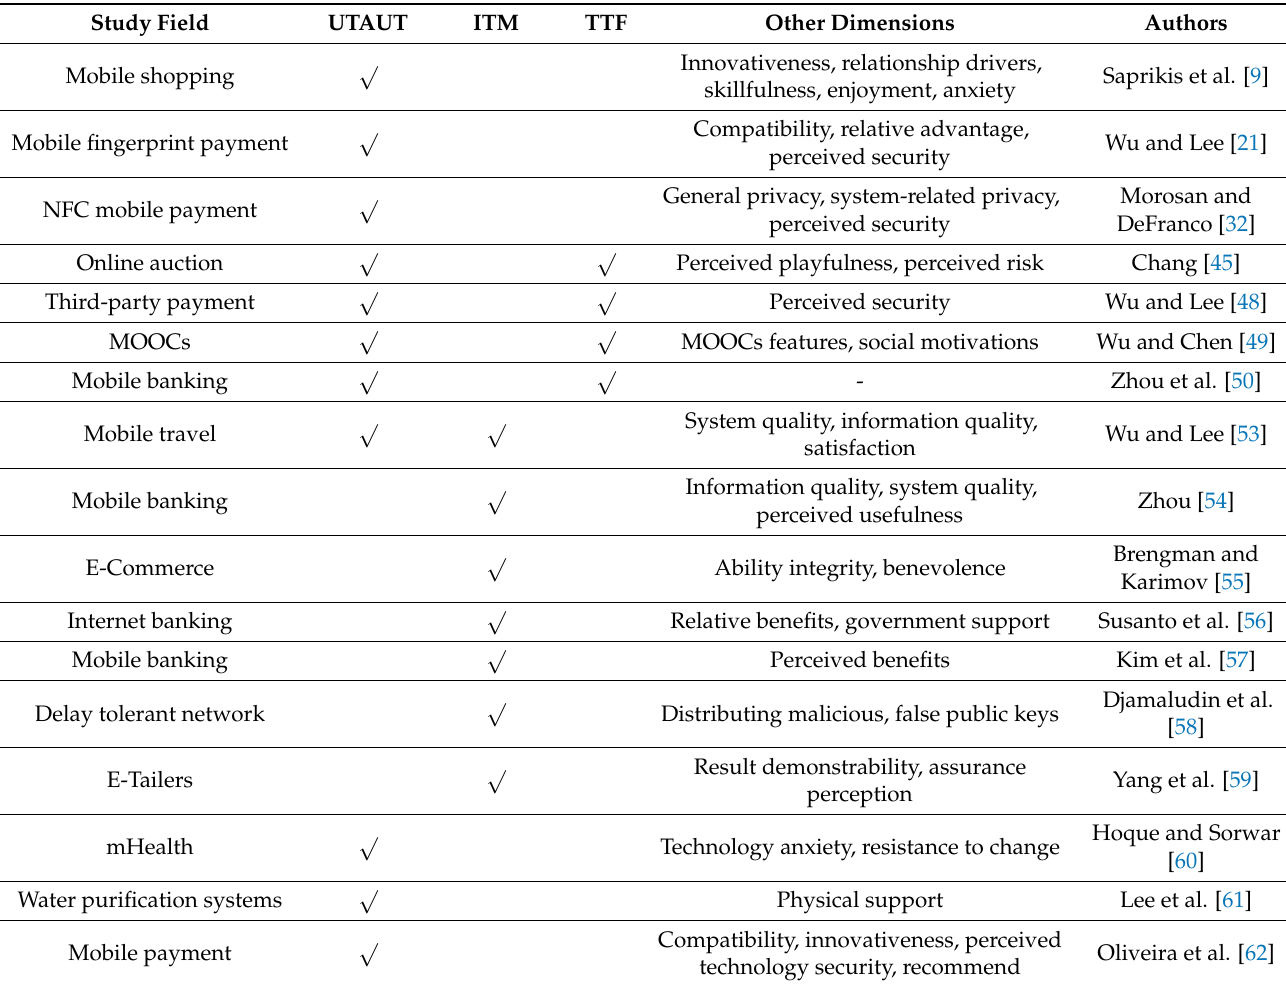
Table 1. Empirical studies using UTAUT, TTF, and